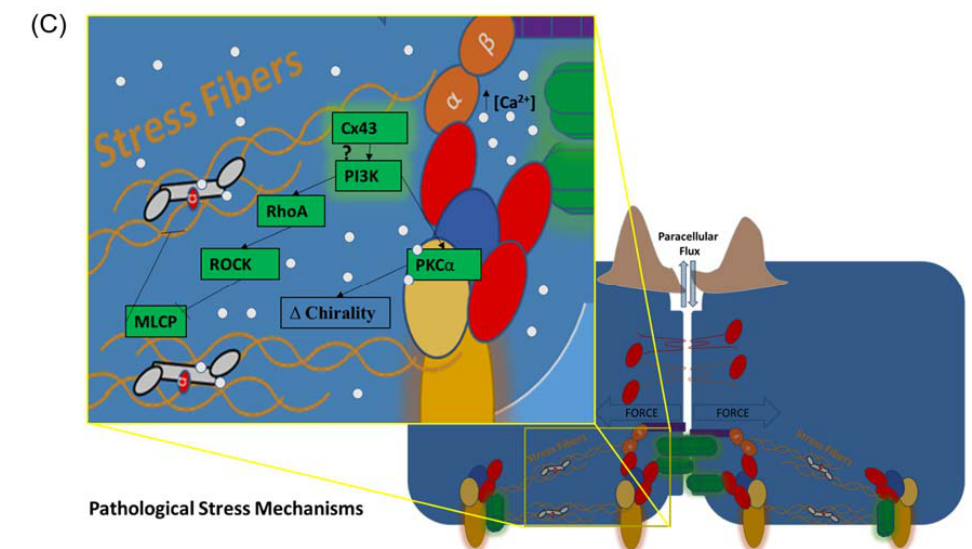
Figure 3. A proposed integrative model for channel-dependent and -independent roles of Cx43 in actin-mediated barrier function pathology. ( A ) A barrier-stabilizing molecular network under normal conditions, including Cx43, focal adhesions, branched cortical actin structures, and transcellular interacting junctional complexes. ( B ) A dynamic shift to actomyosin SF formation, accompanied by upregulation and activation of focal adhesion structures under pathological stress conditions. These processes result in force transmission to AJ-based cell-cell contacts and a breakdown in TJ-regulated barrier function marked by unregulated flux of solutes and ions across the paracellular space. ( C ) Channel-dependent and -independent roles of Cx43 and the Cx43 / ZO1 interaction in the stabilization and alignment of actomyosin pulling forces exerted onto membrane-linked focal adhesion and AJ structures. Under pathological stress conditions, Cx43-based GJs and HCs support Ca 2 + flux, while Cx43 signals via PI3K (by an unknown mechanism) to activate Ca 2 + -dependent SF contraction and PKC α -mediated changes, resulting in a cell chirality-associated breakdown of barrier